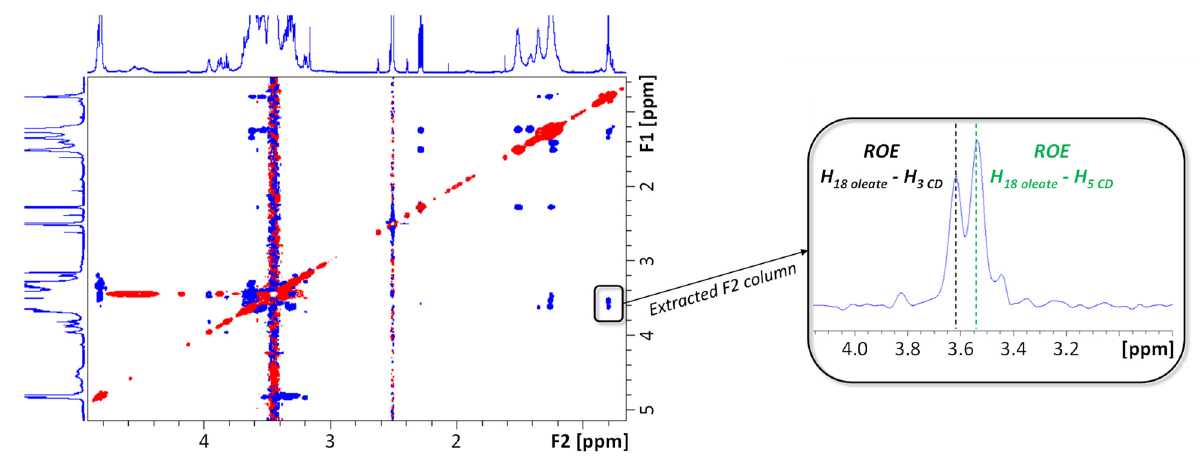
Figure 9. ROESY NMR experiment (600 MHz, DMSO/D 2 O 98/2, v / v , 298 K, t m = 800 ms) of isomer 1 . The extracted columns containing dipolar correlations with H 18oleate (methyl, δ = 0.8 ppm) are inserted and show cross-peak correlations with H 3CD and H 5CD , highlighted by black and green dotted lines, respectively.